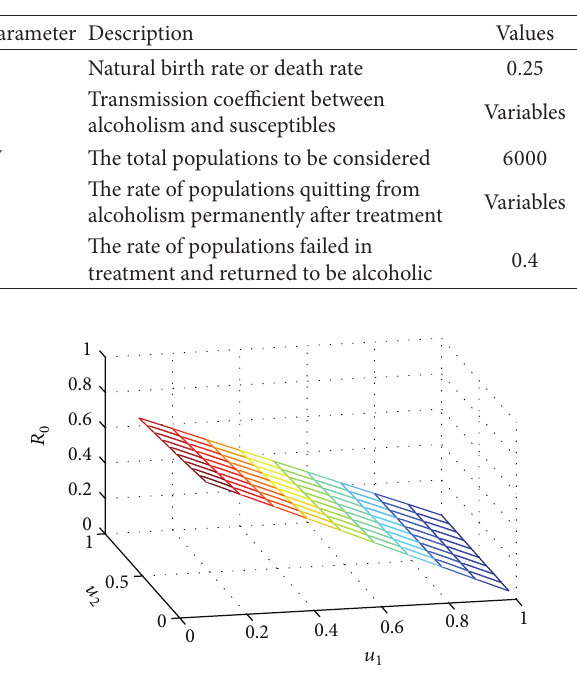
Table 1: The parameters description of model (1).